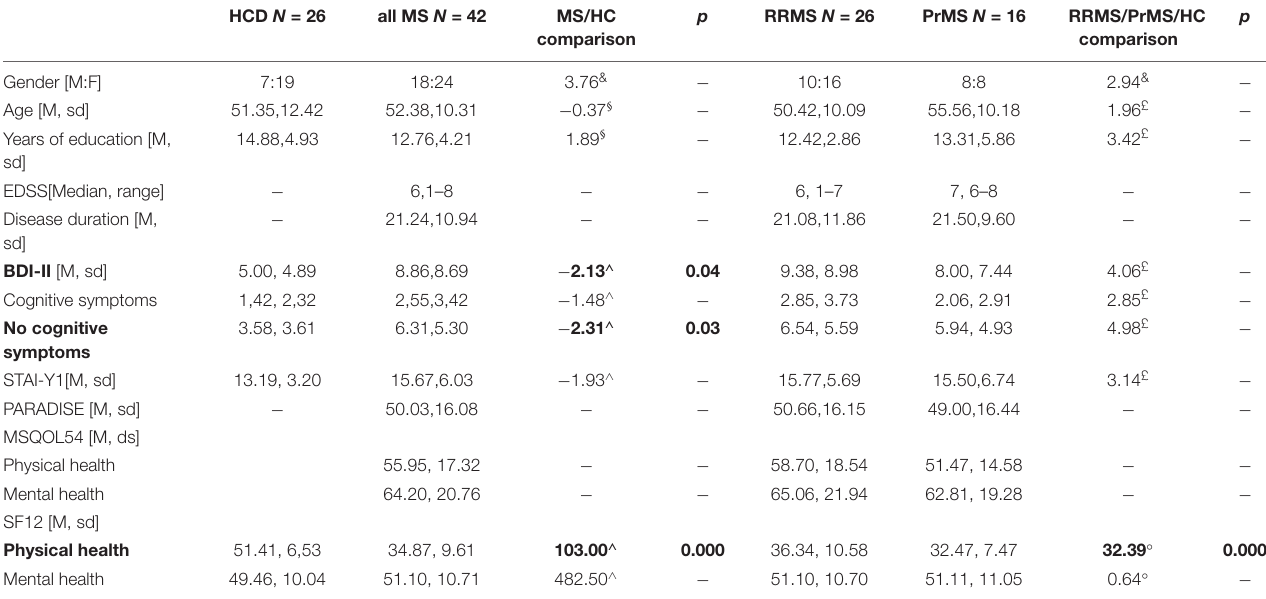
TABLE 1 | Demographic characteristics and group comparison